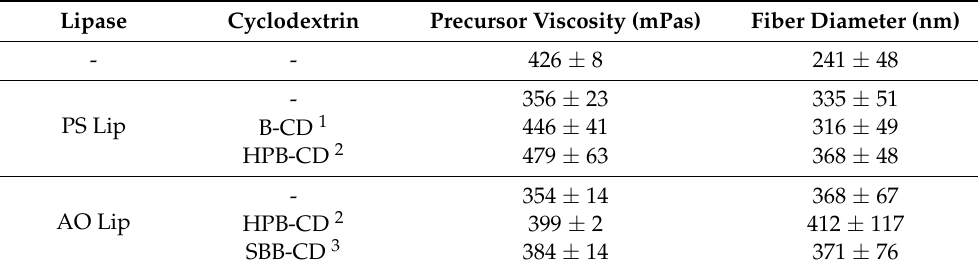
Table 2. Effect of lipases from Burkholderia cepacia (PS Lip) and from Aspergillus oryzae (AO Lip), and cyclodextrins on the viscosity of precursor mixture and on the diameter of nanofibers. Lipase